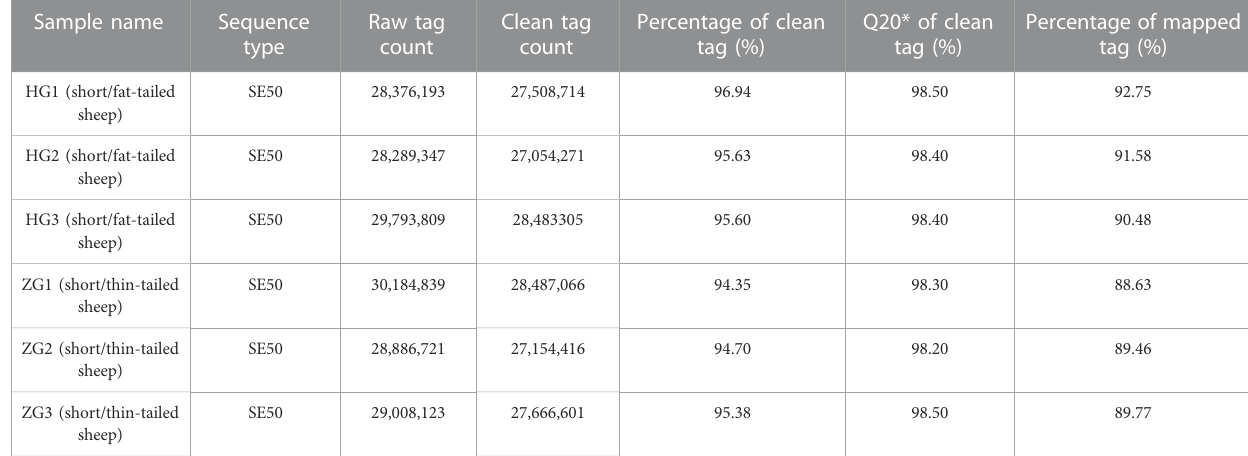
TABLE 1 Summary of sequencing data for each